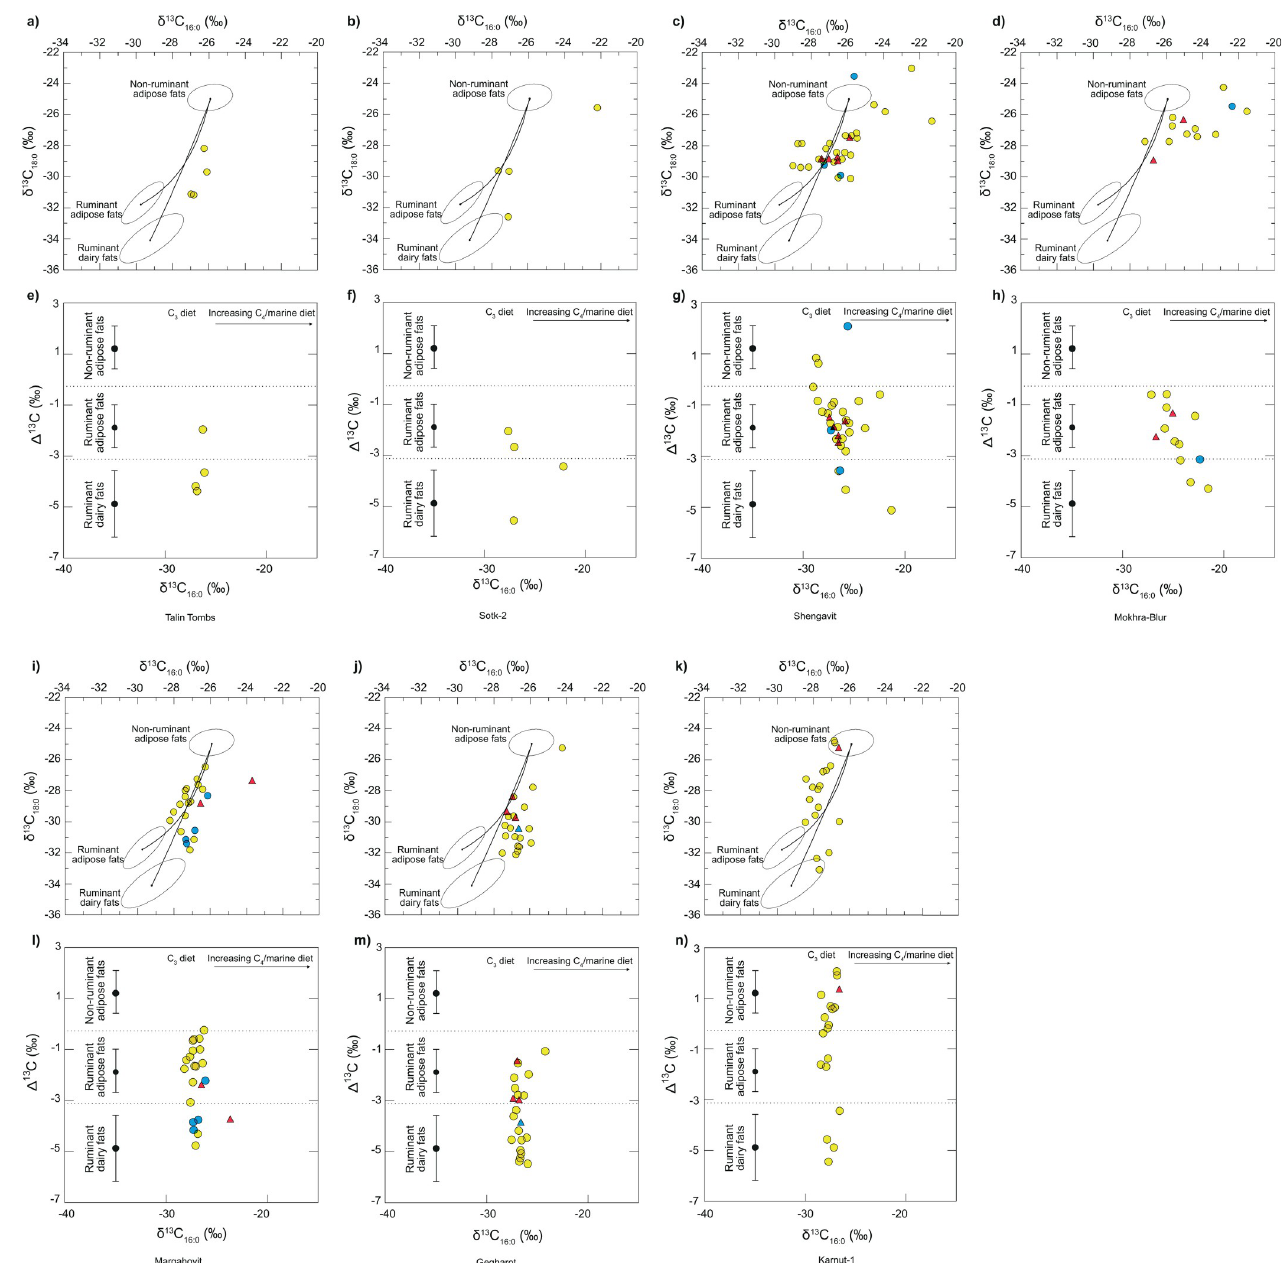
Fig 2. Combined scatter plot showing δ 13 C values of the major fatty acid components ( n -C 16:0 and n -C 18:0 ) prepared from lipid extracts from examined sites. Shengavit (c, j), Gegharot (f, m), Karnut-1 (g, n), Margahovit (e, l), Sotk-2 (b, i), Mokhra-Blur (d, k) and Talin Tombs (a, h). Each data point corresponds to an individual vessel. Residues with evidence of plant processing, see S3 Table for labelled data points. Plots ( a-g ): The values of reference fats are represented by confidence ellipses ( ± 1 σ ) for animals raised on a strict C 3 diet [46]. The three annotated fields correspond to P = 0.684 confidence ellipses relating to modern fats of animals raised on a purely C 3 diet in Britain [46]. Plots ( h-n ): The difference in the δ 13 C values of the n -C 18:0 and n -C 16:0 fatty acids ( Δ 13 C = δ 13 C 18:0 - δ 13 C 16:0 ) obtained for the n -C 16:0 and n -C 18:0 fatty acids prepared from lipid extracts from all sites. Ranges depicted represent the mean ± 1 s.d. of Δ 13 C values for a global database published elsewhere comprising modern reference animal fats from various geographical settings that include: Africa [86], UK [44], Kazakhstan [95], Switzerland [96], and the Middle East [97]. Triangle symbols represent TLEs with evidence of plant processing with CPI values > 5; blue symbols represent TLEs with evidence of aquatic components (APAAs and IFAs). Analytical precision is ± 0.3‰.